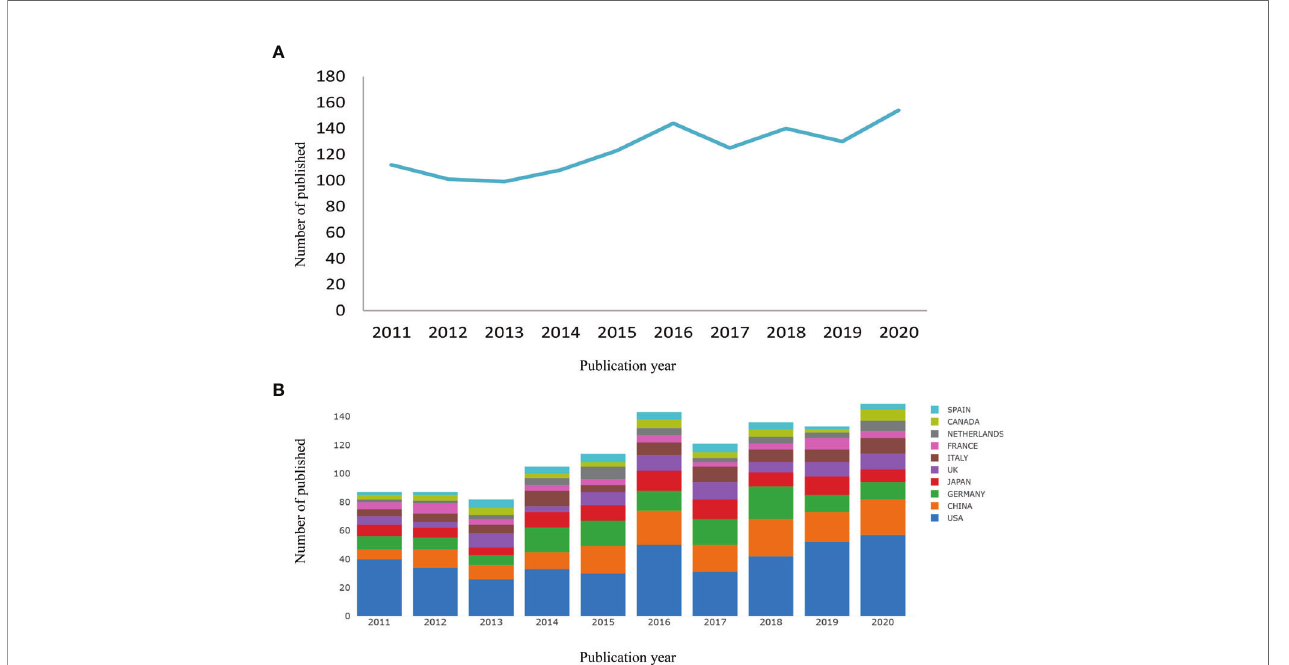
FIGURE 2 | Output of related literature. The number of annual publications (A) and growth trends of the top 10 countries/regions (B) in craniopharyngioma research from 2011 to 2020. Conducted by online analysis platform of